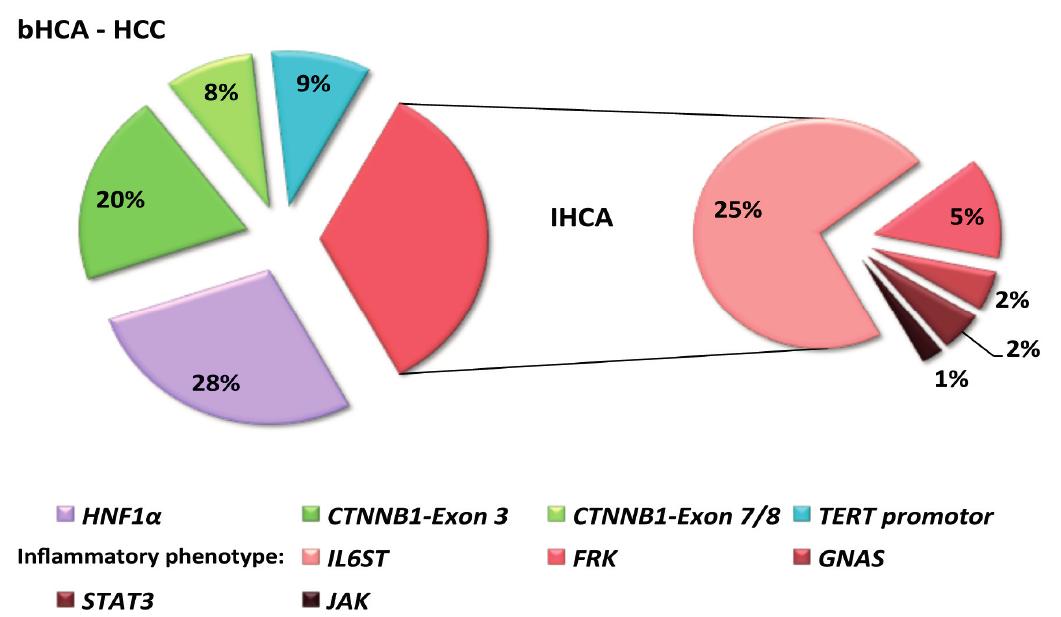
Figure 4. Spectrum of molecular alterations in well-differentiated hepatocellular